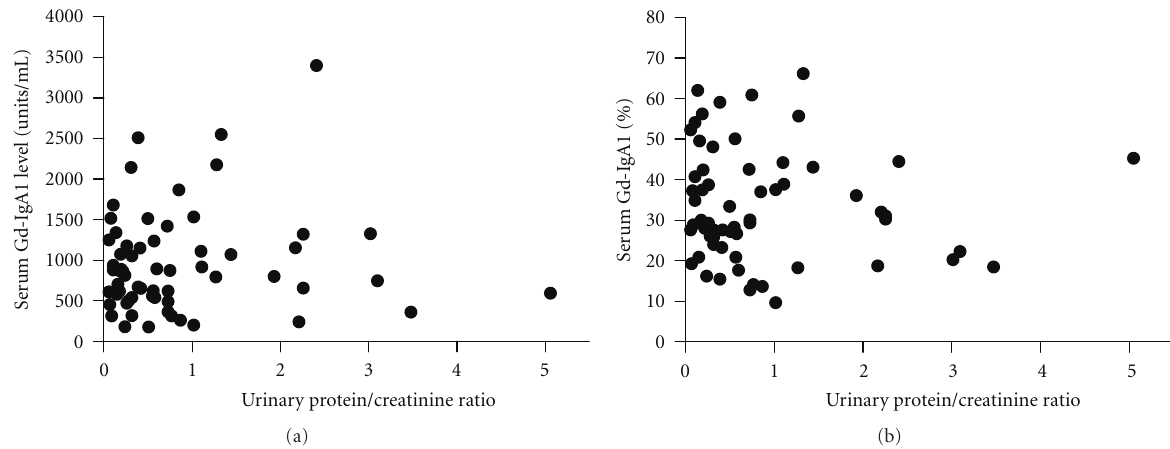
Figure 2: Random urinary protein/creatinine ratios. (a) Plotted against serum Gd-IgA1 levels. Spearman’s rank correlation is r = 0 . 05, P = 0 . 72. (b) Plotted against percent Gd-IgA1 levels. Spearman’s rank correlation is r = − 0 . 11, P = 0 . 38.